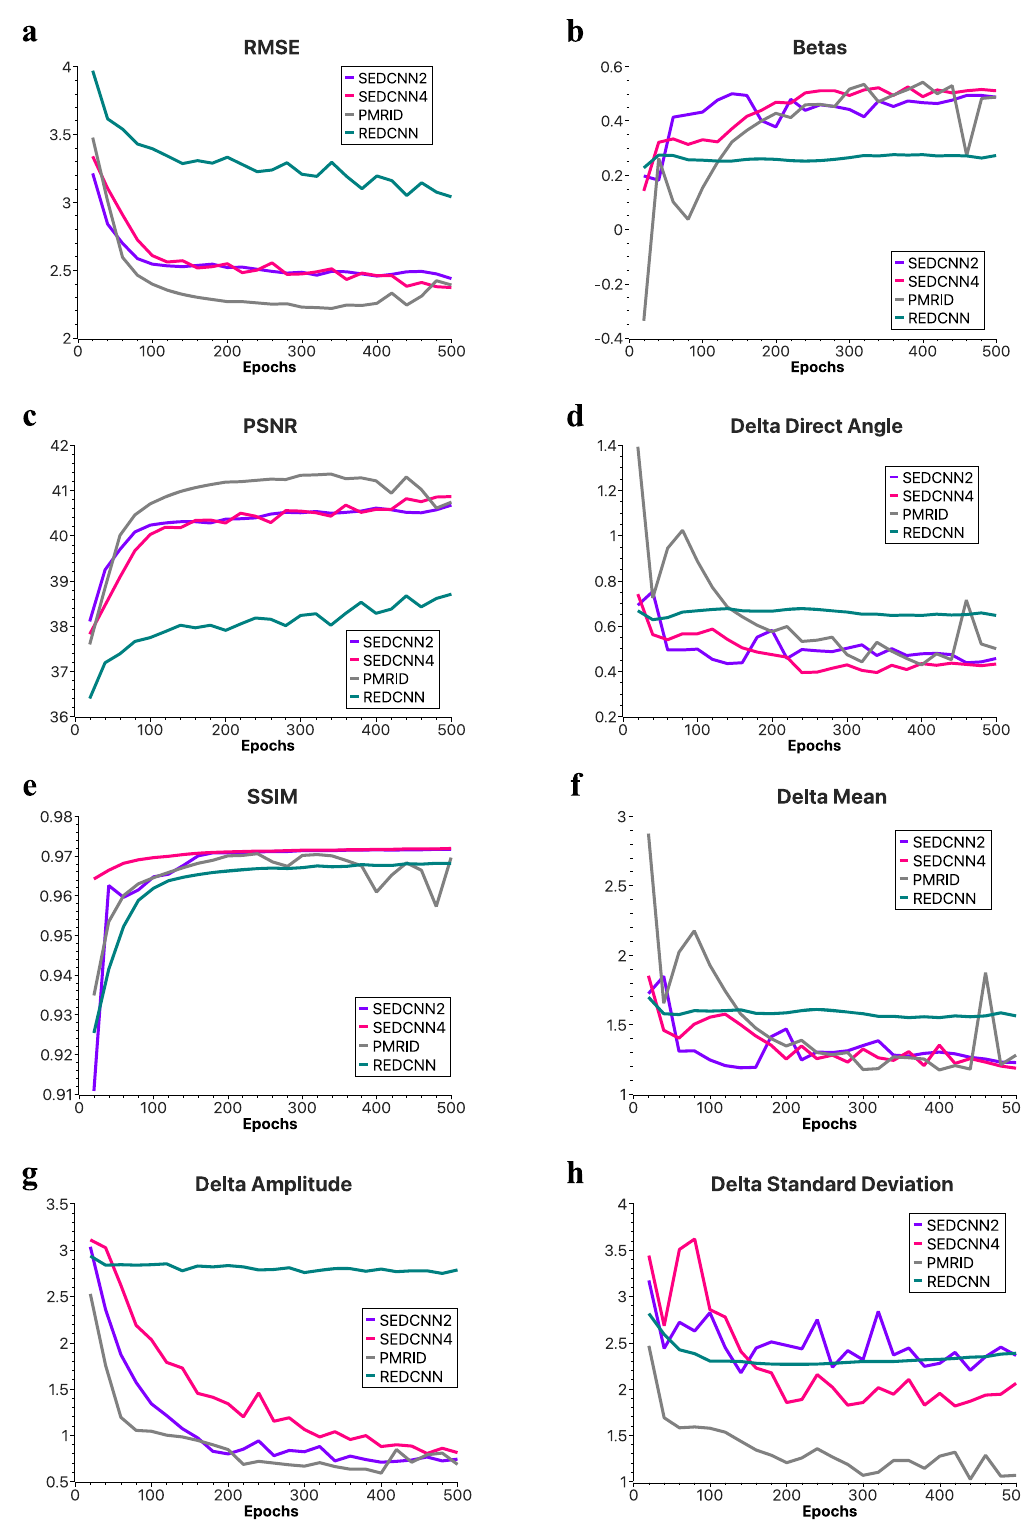
Fig. 4 Performance comparison using various metrics. Performance of networks under optimal hyperparameter con fi gurations using various metrics, including a RMSE, b Betas, c PSNR, d Delta Direct Angle, e SSIM, f Delta Mean, g Delta Amplitude, h Delta Standard Deviation. Two variants of SEDCNN, PMRID, and REDCNN were compared. Units: RMSE, PSNR, SSIM, Betas are in arbitrary units; Delta Amplitude is in image intensity values; Delta Direct Angle, Delta Mean, Delta Standard Deviation are in degrees. The number of epochs was set to